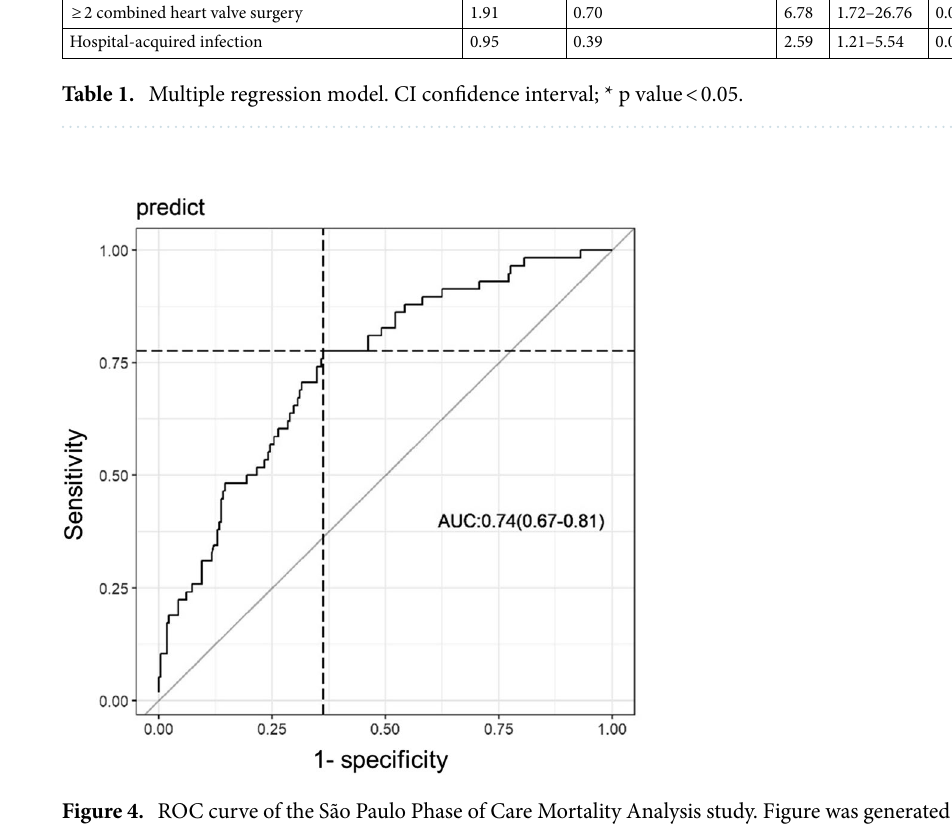
Figure 4. ROC curve of the São Paulo Phase of Care Mortality Analysis study. Figure was generated using R statistical software version 3.6.0 15